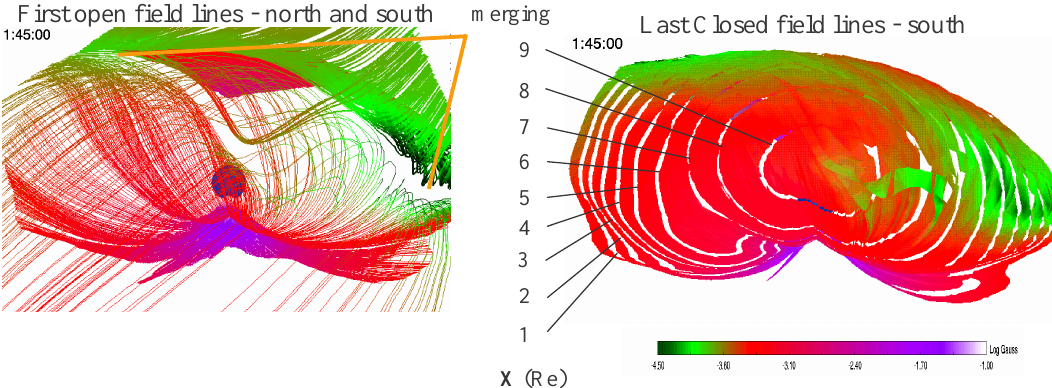
Fig. 17. The right panel expands Fig. 16f and builds the magnetopause in 1R E segments to show the 3-D aspects of the surface with a negative 135 ◦ clock angle, negative B X and a − 23 ◦ dipole tilt, characteristic of winter and similar to the event discussed (note that the clock angle is negative so that post-noon features in the data would be seen pre-noon in the simulation). The left plot traces the first open field lines from both Northern and Southern Hemisphere cusps. Open field lines from opposite hemispheres meet over the green areas in the right panel, which we identify as proxies for merging locations. The dip near noon is different from all other Northern Hemisphere open field lines and matches Southern Hemisphere lines that meet. This is a transient event in the